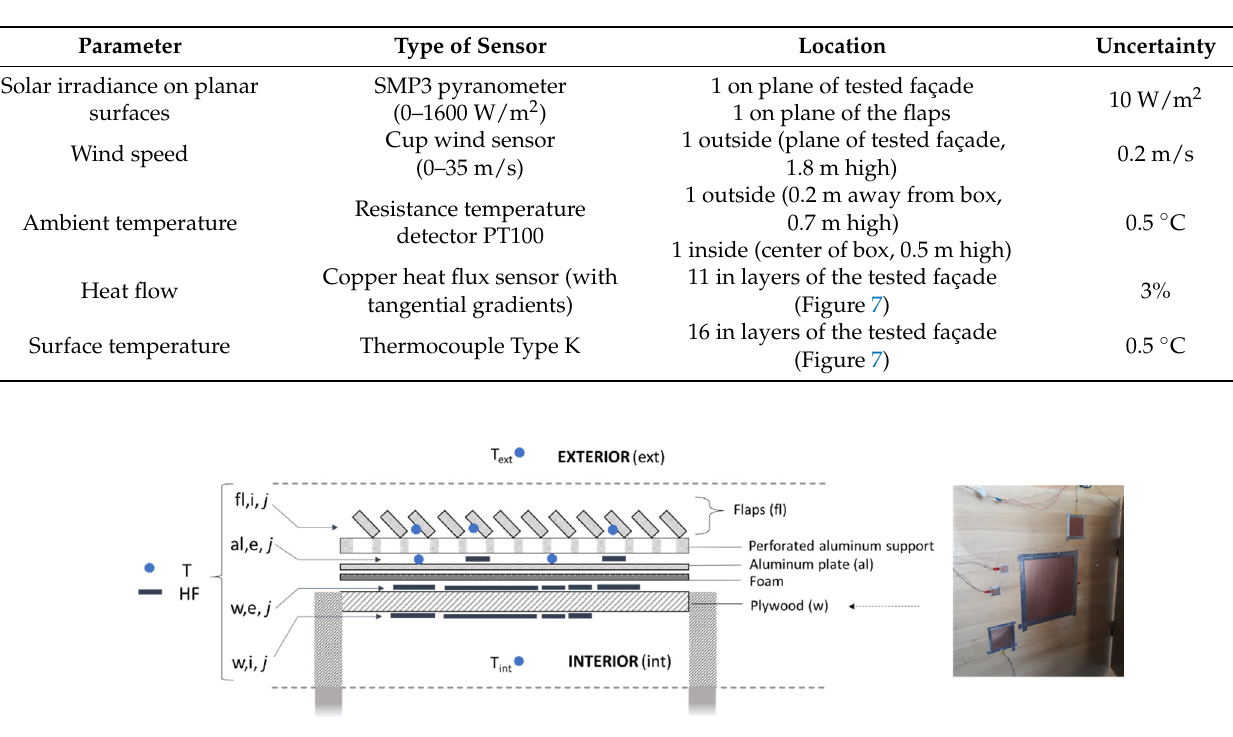
Figure 7. Repartition and nomenclature of temperature (T) and heat flux (HF) sensors using a top-view diagram of the Stegos + wall of the test box.